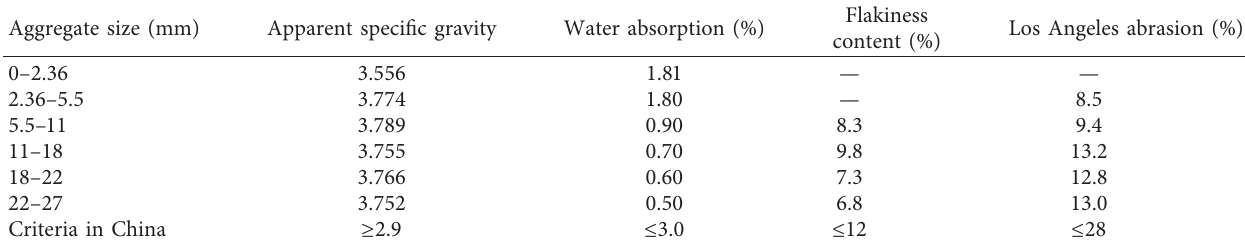
Table 2: Fundamental properties of BOF slag.